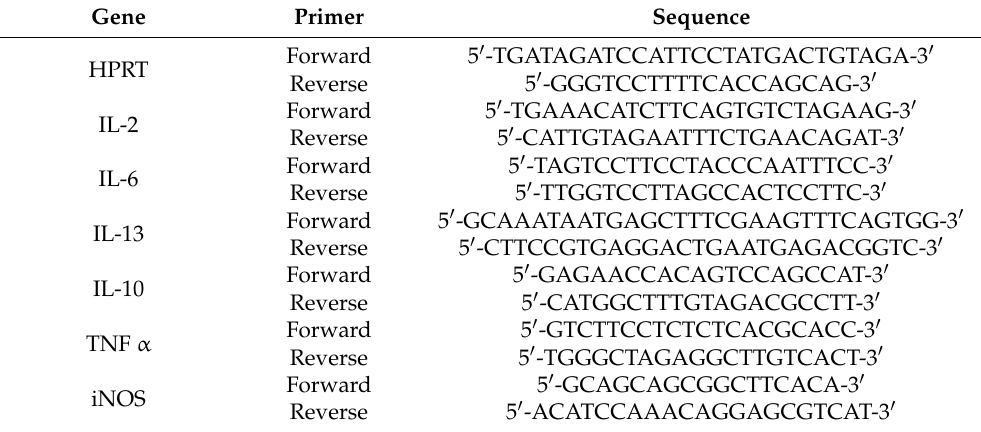
Table 1. Sequences of